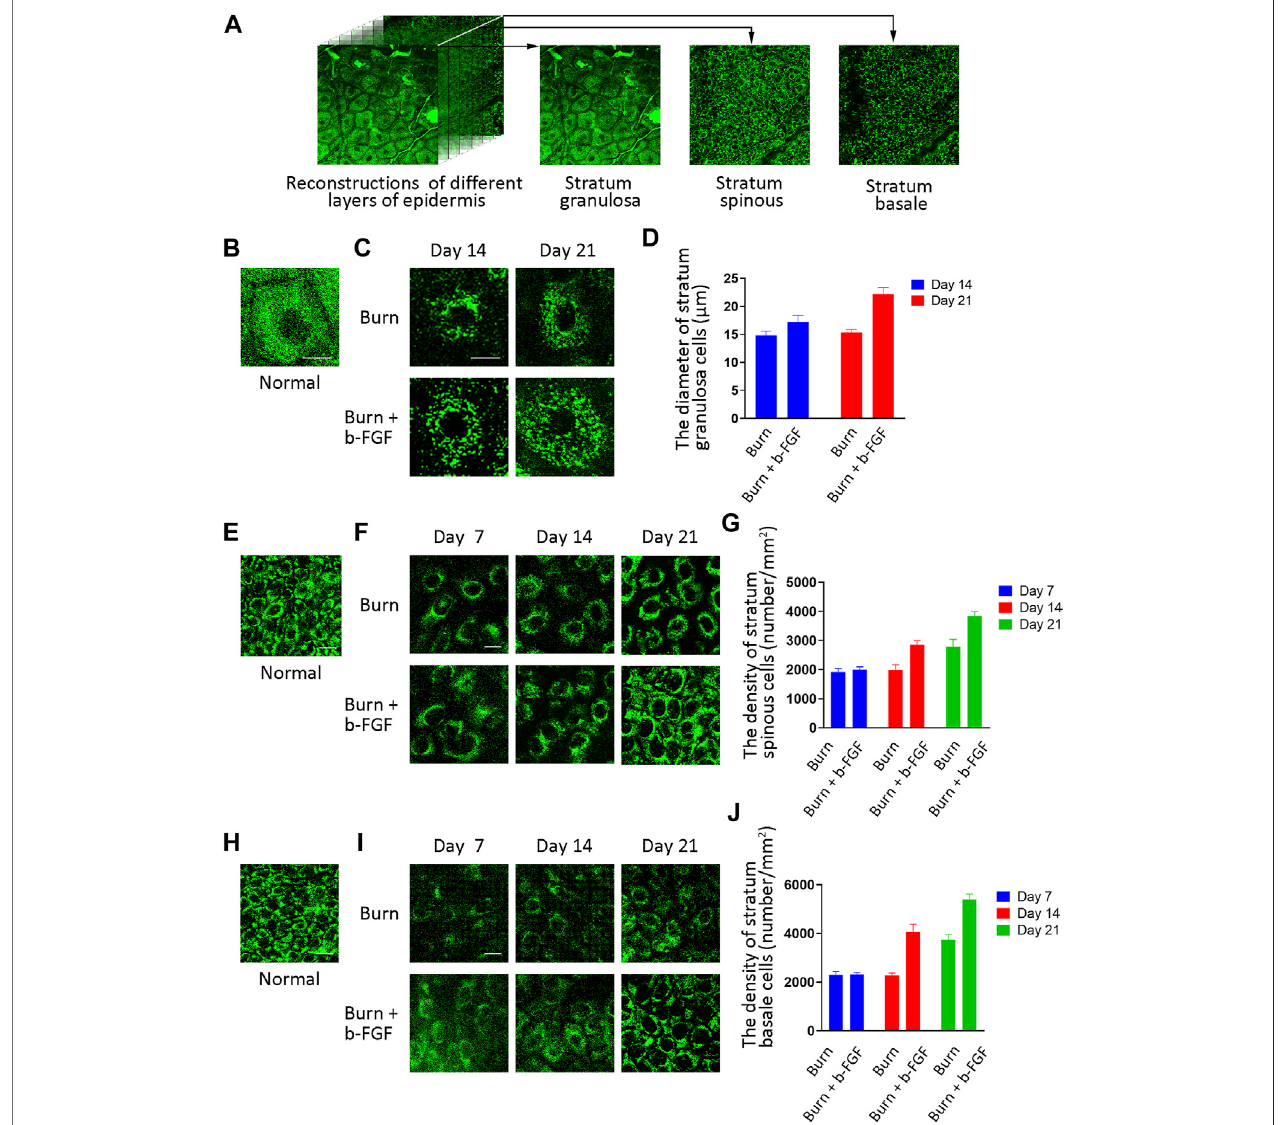
FIGURE3| EpidermalhealingassessmentofthedeepburnsfromNAD(P)HimagesbyTPMinmice. (A) Reconstructionsofdifferentlayersoftheepidermis. (B) Cell morphologyofthestratum granulosumfromNAD(P)Himages innormalskin.TheareaofNAD(P)Himages was33 μ m×33 μ m.Scalebar=10 μ m. (C) Cellmorphology of the stratum granulosum from NAD(P)H images between the Burn group and the Burn + b-FGF group. The area of NAD(P)H images was 33 μ m × 33 μ m. Scale bar = 10 μ m. (D) Cell diameter of stratum granulosum was calculated. (E) Images of stratum spinosum from NAD(P)H images in normal skin. The area of the NAD(P)H images was 56 μ m × 56 μ m. Scale bar = 10 μ m. (F) Images of stratum spinosum from the NAD(P)H images between the Burn group and the Burn + b-FGF group. The area ofthe NAD(P)H images was 56 μ m × 56 μ m. Scale bar = 10 μ m. (G) Image number ofstratum spinosum wascalculated. (H) Cells of stratum basale from NAD(P)H images in normal skin. The area of NAD(P)H images was 56 μ m × 56 μ m. Scale bar = 10 μ m. (I) Cells of stratum basale from the NAD(P)H images between the Burn group and the Burn + b-FGF group. The area of the NAD(P)H images was 56 μ m × 56 μ m. Scale bar = 10 μ m. (J) Cell number of stratum basale was